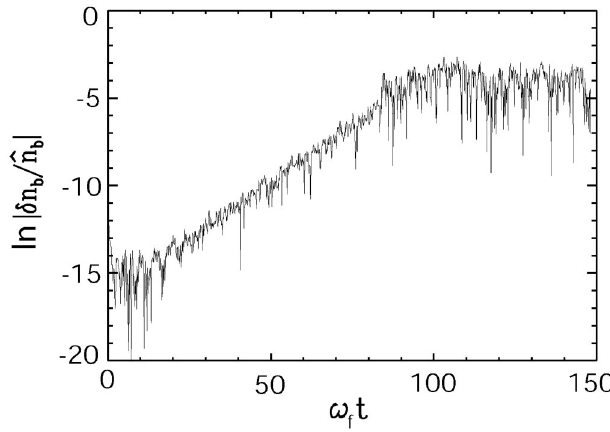
FIG. 3. Time history of the normalized density perturbation (cid:7) 0 : 8 and T (cid:7) 0 : 02 at fixed axial po- = ^ n (cid:31)n for s k b =T ? b b b max sition z and radius r (cid:7) 0 : 3 r for the same conditions as b